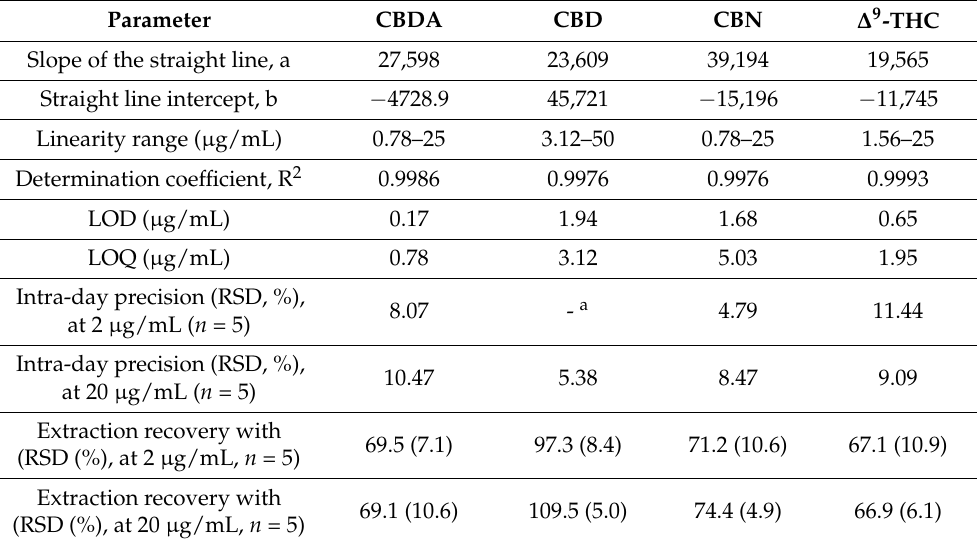
Table 2. Validation parameters for determination of CBDA, CBD, CBN and ∆ 9 -THC in oil matrix by HPLC-DAD. CBDA CBD CBN